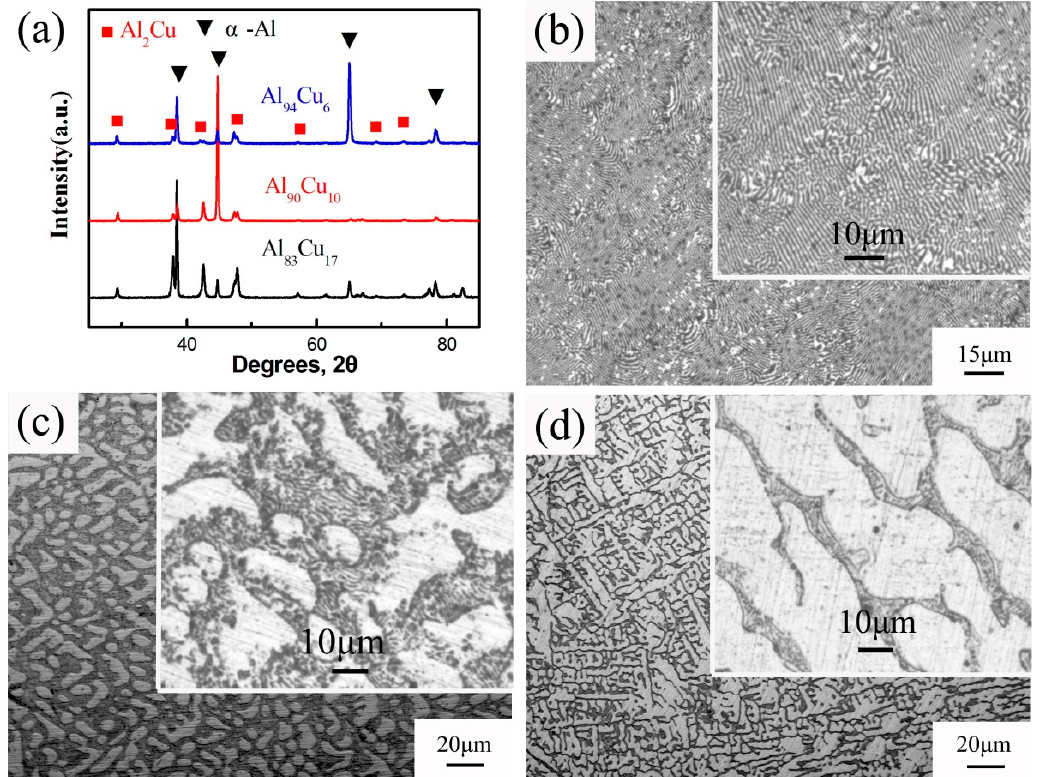
Figure 1. ( a ) X-ray di ff ractometry (XRD) patterns of alloys and their optical microscopy (OM) micrographs of the ( b ) Al 83 Cu 17 , ( c ) Al 90 Cu 10 and ( d ) Al 94 Cu 6 . The up-insets in ( b–d ) show their magnified views of the corresponding microstructures.